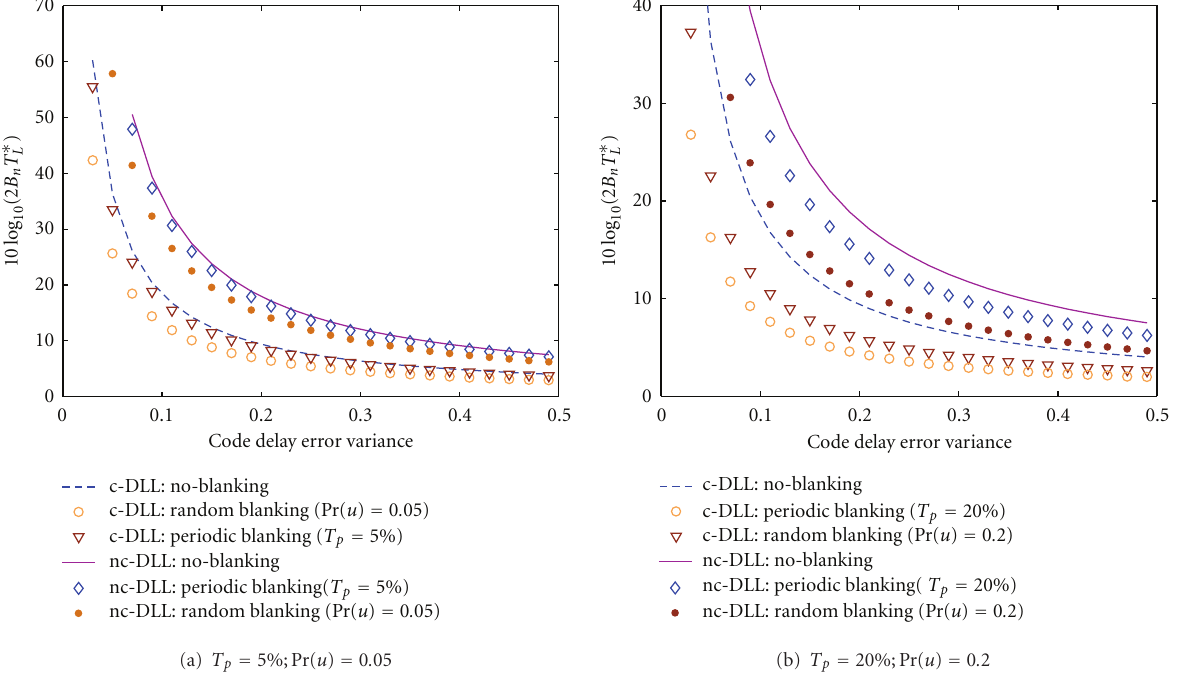
Figure 5: MTLL (a) T p = 5%, and Pr( u ) = 0 . 05 (b) T p = 20%, and Pr( u ) = 0 . 2.